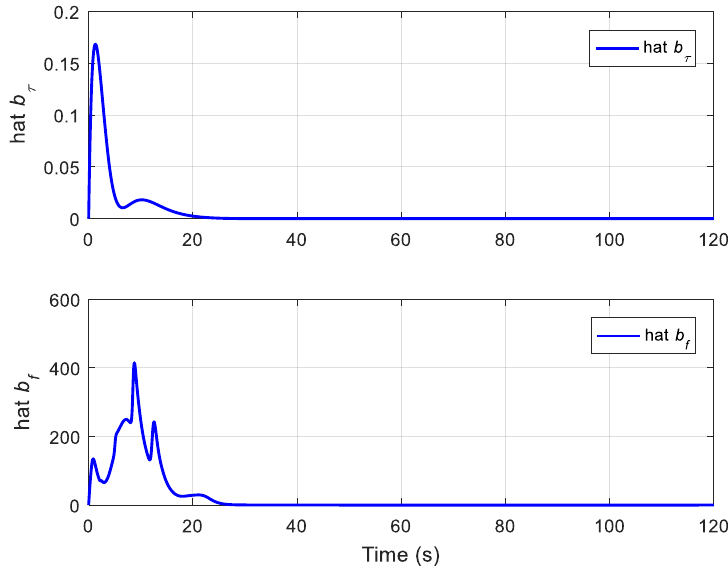
Figure 7. Two adaptive parameters under the proposed controller.